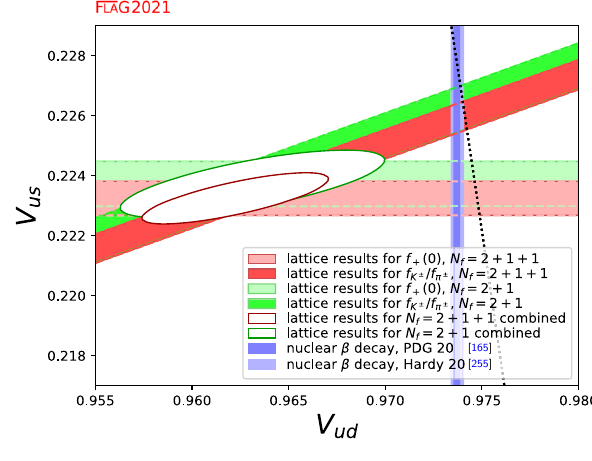
Fig. 11 Same as Fig. 10 but with | V us | / | V ud | through Eq. (70)